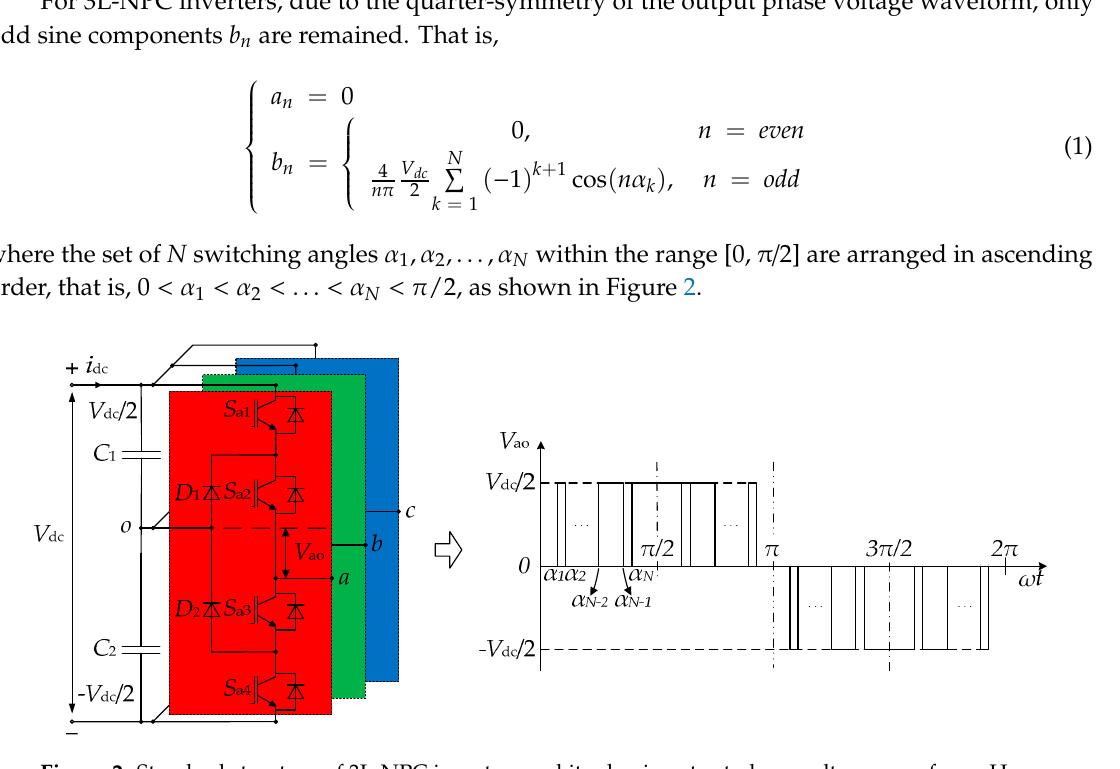
Figure 2. Standard structure of 3L-NPC inverters and its classic output phase voltage waveform. Here, N = odd.